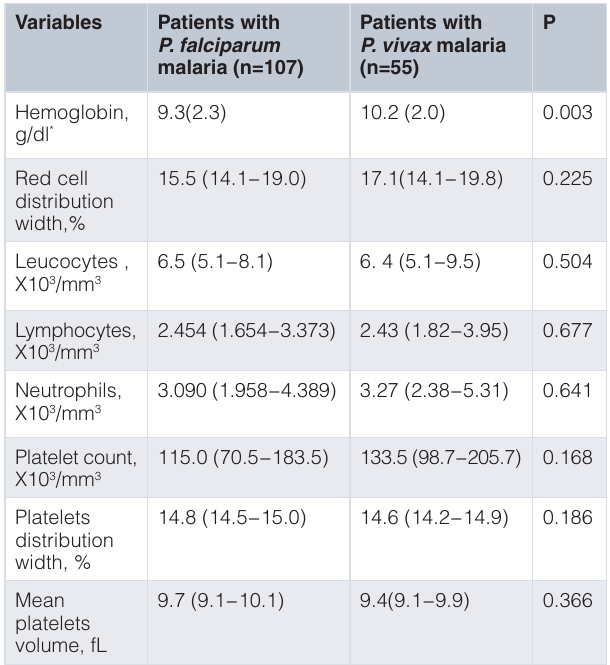
Table 4. Binary logistic regression analysis of the factors associated with P. falciparum and P. vivax malaria in eastern Sudan. �R: odds ratio.�R: odds ratio.